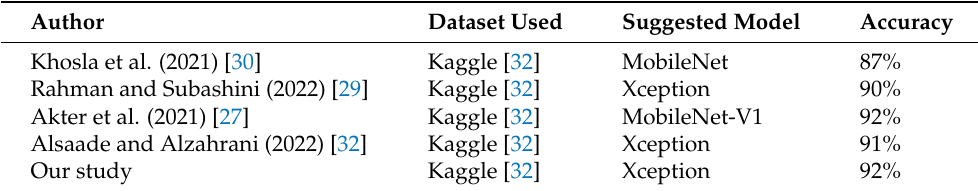
Table 11. Performance comparison of the recent research.